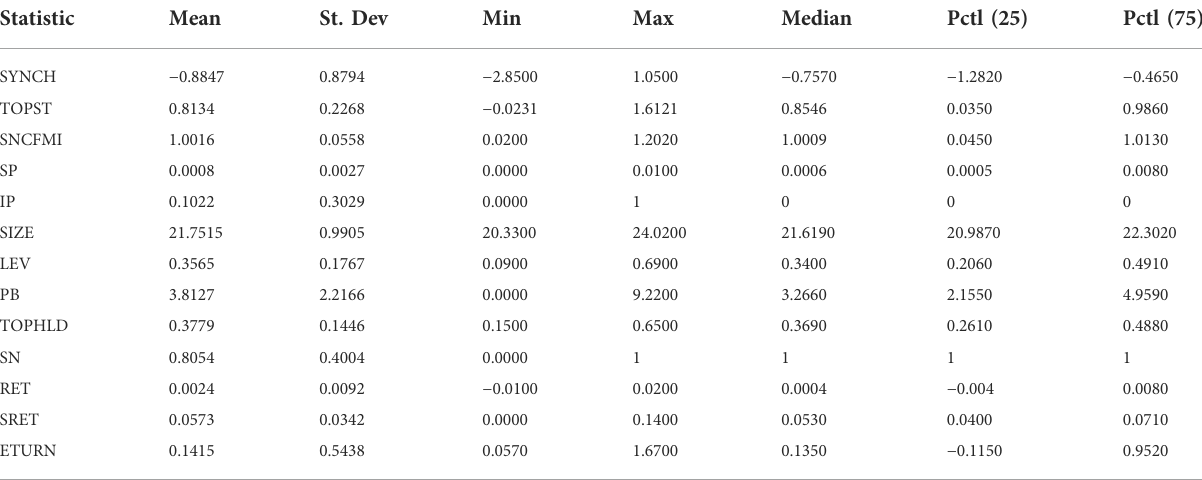
TABLE 1 Descriptive statistics.